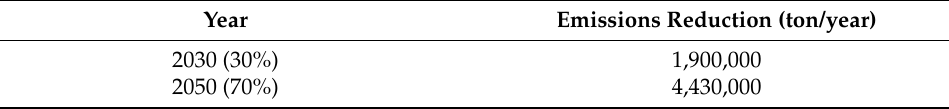
Table 15. Thermoelectric plants—CO 2 emissions